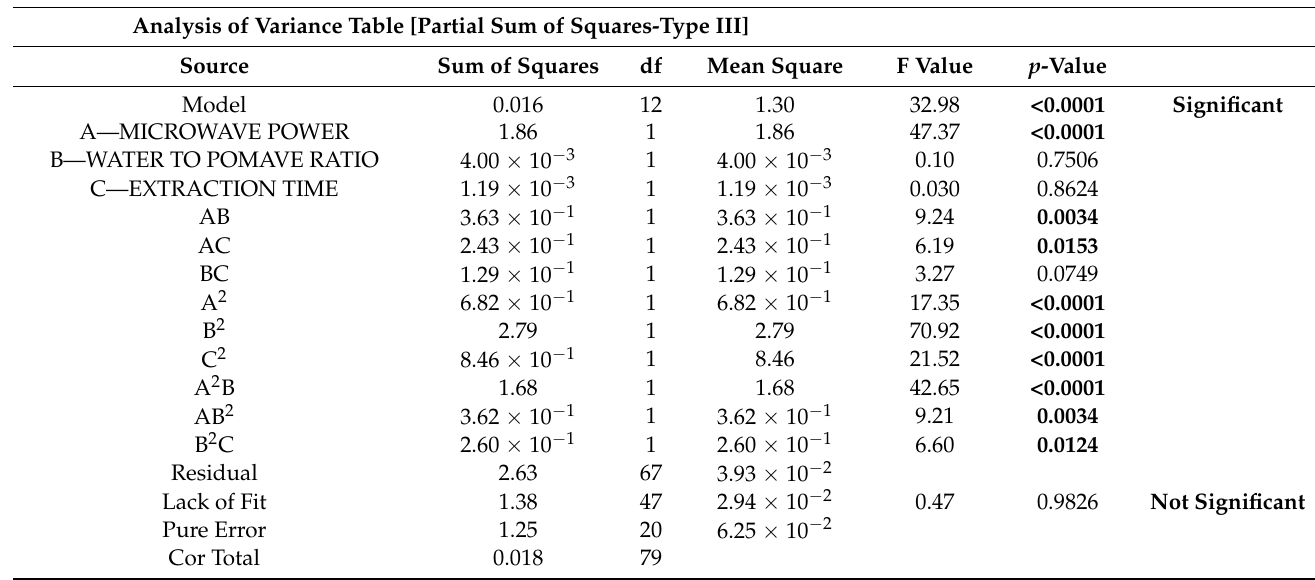
Table 3. Analysis of variance (ANOVA) of the derived model for prediction of the amount of the total flavonoids in OP extracts. ANOVA for Response